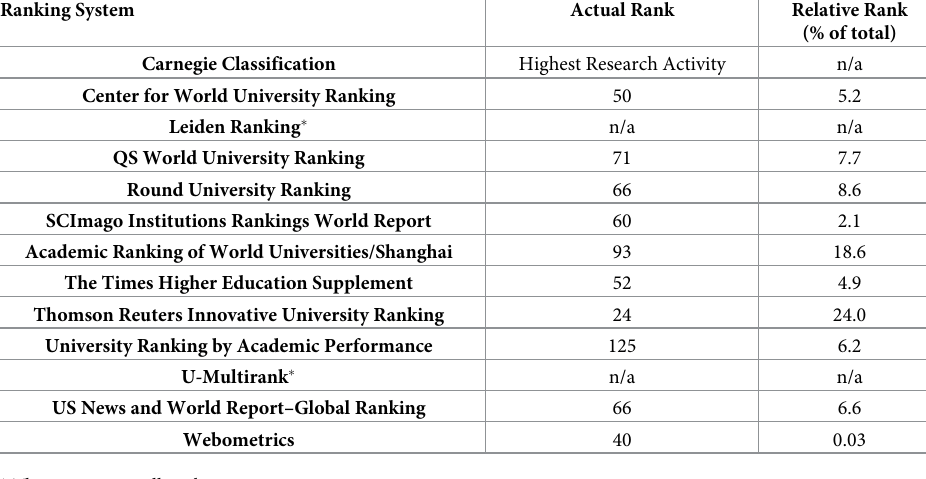
Table 8. Conflicting global rankings of an illustrative research university (per most recent published results, 2016). Ranking